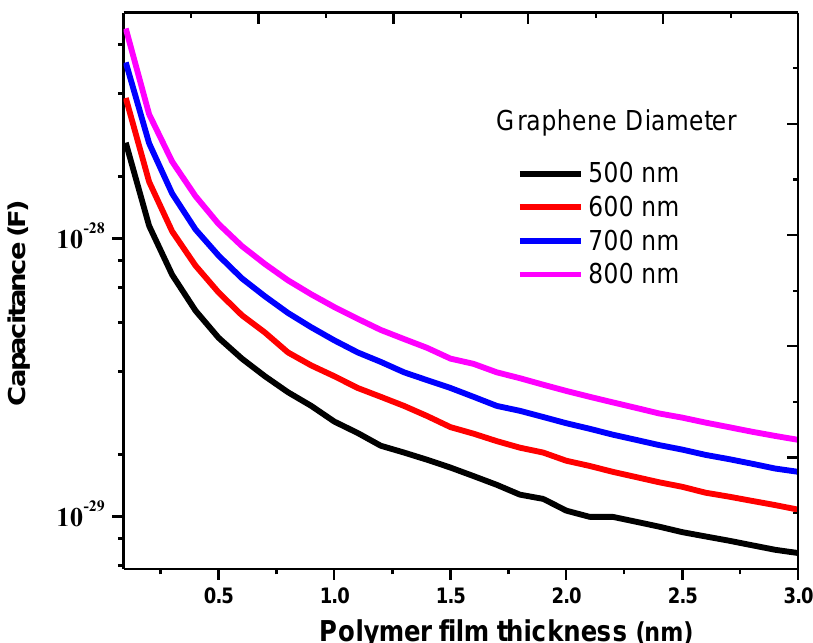
Figure 6. Capacitance of the junction as a function of graphene diameter and insulation thickness.